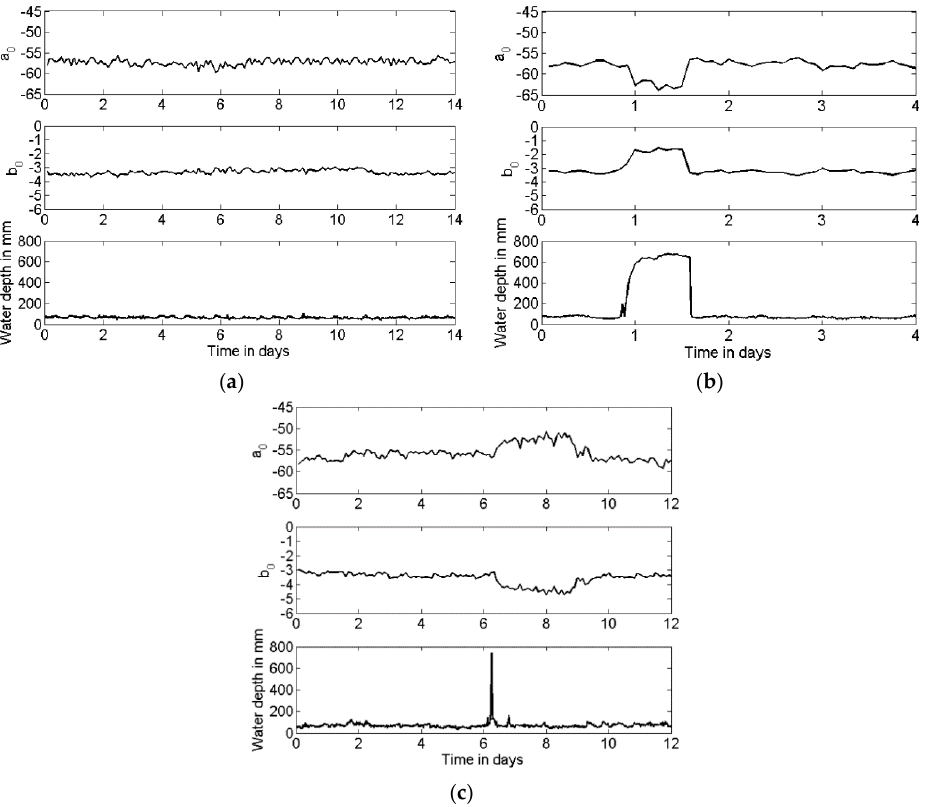
Figure 13. Examples of data collected in phase 2 over a six-month period: ( a ) ambient dry weather flow; ( b ) a longer term storm event which does not result in a change in screen condition; ( c ) a short-term storm event which resulted in a change in screen